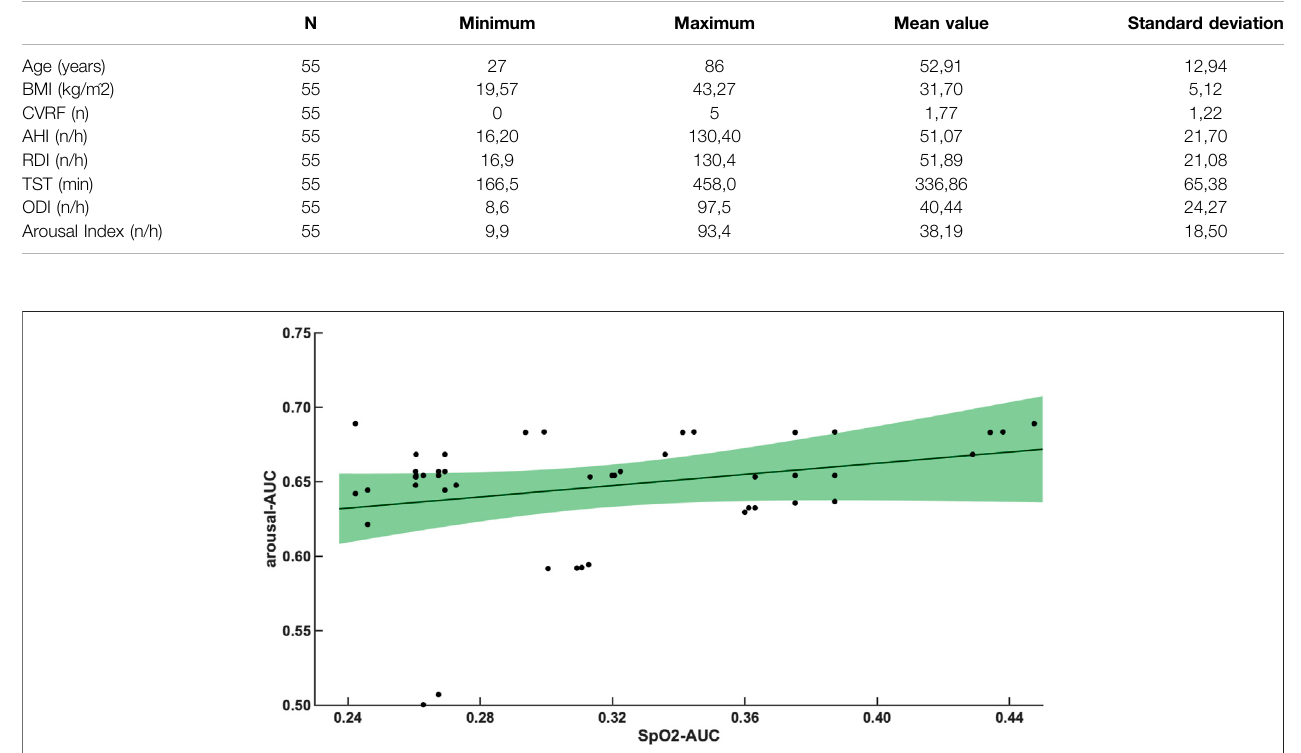
TABLE 2 | The epidemiological data of the 55 patients with AHI between 15 and 30/h shows age in years, BMI in kg/m 2 , CVRF for the number of cardiovascular risk factors (hypertension, Obesity, diabetes mellitus, hyperlipoproteinemia), AHI in number per hour, RDI (Respiratory Disturbance Index) in number per hour, TST (total sleep time) in minutes, ODI (oxygen desaturation index) in number per hour and Arousal Index in number per hour.